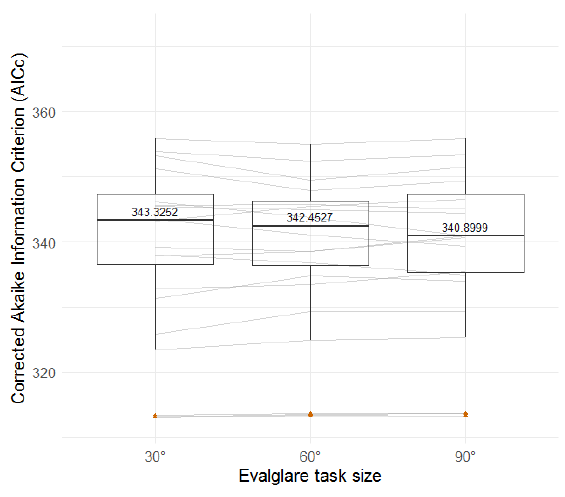
Figure 29. Boxplots of AICc for the three task area sizes (laboratory study).